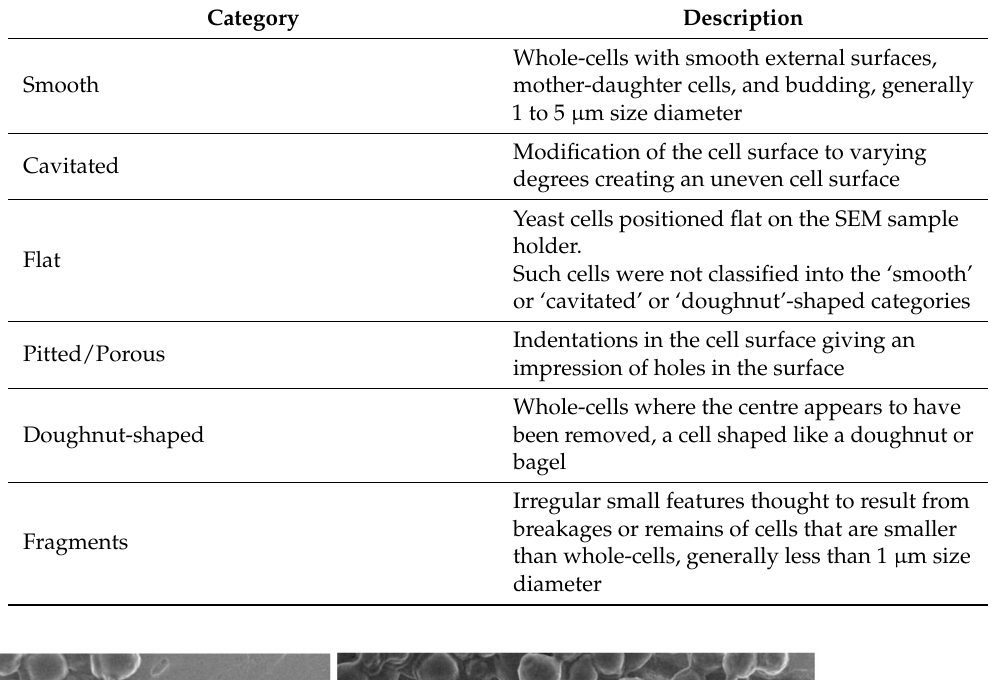
Table 1. Description of categorisation of whole-cell features of S. cerevisiae.